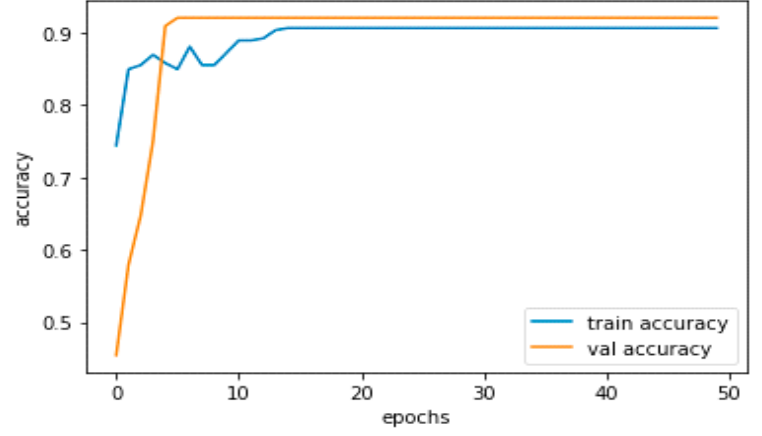
Figure 10. Model training accuracy.